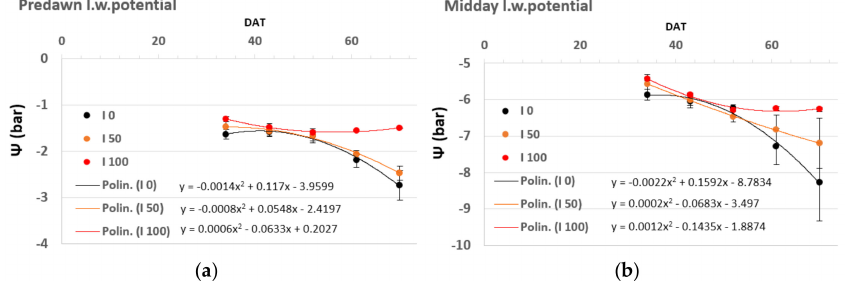
Figure A1. Statistical elaboration of data presented in Figure 2( a ) Predawn and ( b ) midday water potentials of fully irrigated (I 100 ), moderately water-stressed (I 50 ) and severely water-stressed (I 0 ) spearmint plants along the growth cycle. Values are means ± 1 S.E. In the figures are reported the equation that governs the predawn and midday water potentials